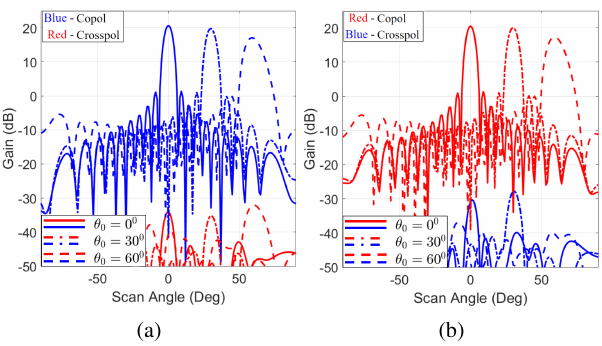
FIGURE 6: Gain pattern for a 2X20 array with (a) H and (b) V polarization and spacing = 0 . 5 λ